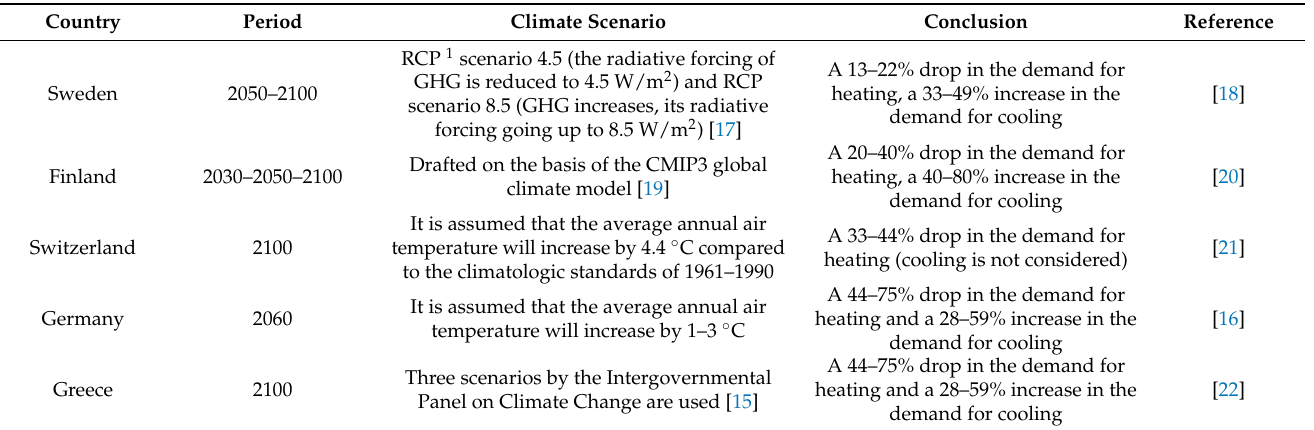
Table 1. A summary of previous studies pertaining to the effect of climate change on residential buildings in